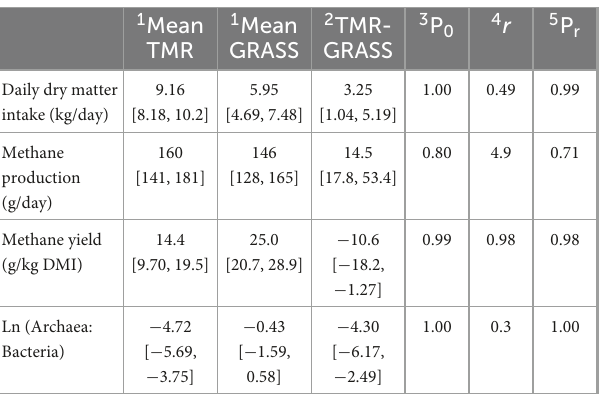
TABLE 2 Means and differences between diets [fresh cut grass (GRASS) and high concentrate (TMR)] in daily dry matter intake (kg/day), methane traits and natural log archaea to bacteria